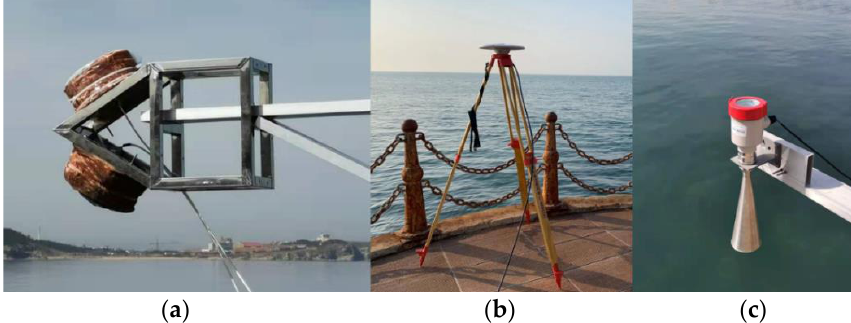
Figure 5. The instruments in the experiment. ( a ) the dual antennas; ( b ) the choke ring antenna for positioning; ( c ) the radar